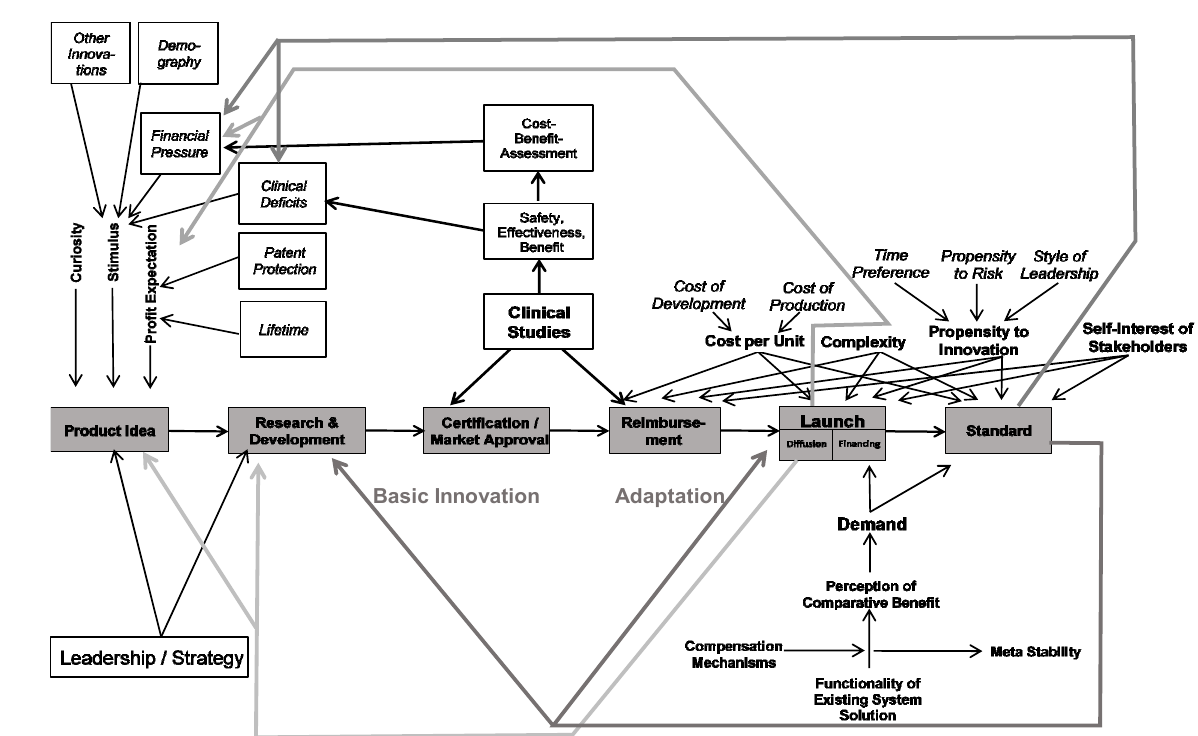
Figure 6. Phase Model of the Development of an Implant.